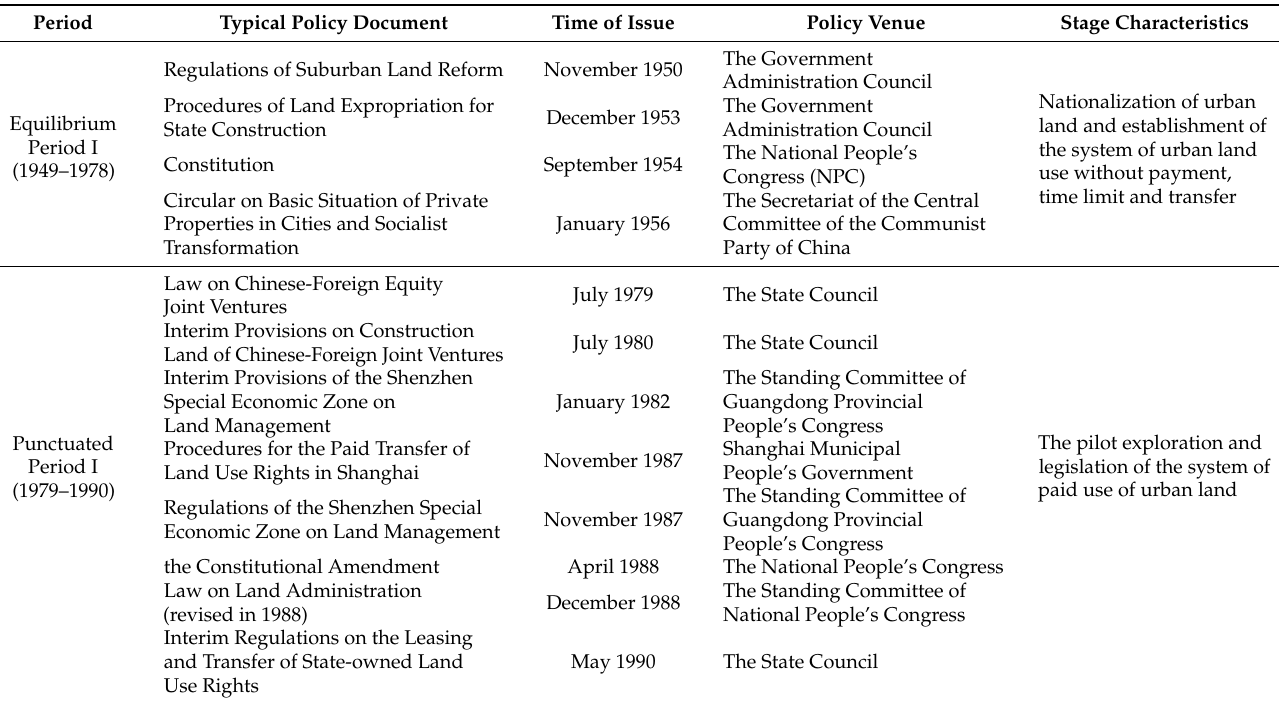
Table 2. The stage characteristics of five policy periods during the process of China’s urban land system reform